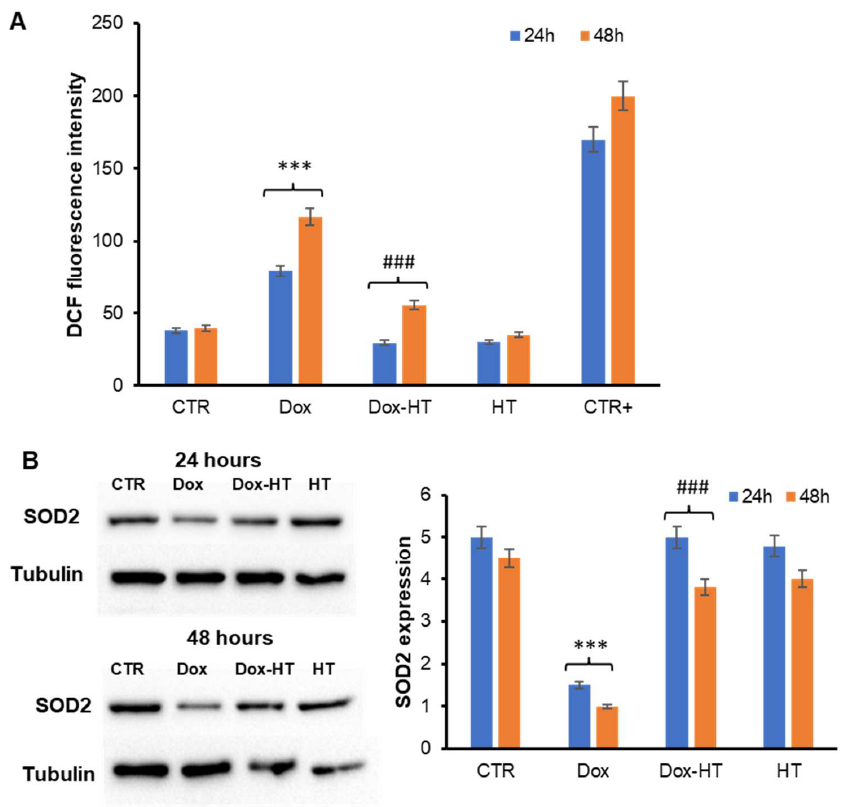
Figure 4. Role of HT in Dox-induced oxidative stress. H9c2 cells were exposed to 0.1 μM Dox (Dox) and co-incubated with 50 μM HT (Dox–HT), and both ROS production by DCFH-DA assay ( A ) and SOD2 expression by western-blot analysis ( B ) were evaluated. CTR: untreated cells; HT: cells treated with HT only; CTR+: cells treated with 1.0 mM H 2 O 2 . Data are expressed as average ± S.D. from five independent experiments carried out in triplicate. Other experimental details are described in the Materials and Methods section. *** p ˂ 0.001 versus CTR, ### p ˂ 0.001 versus Dox.